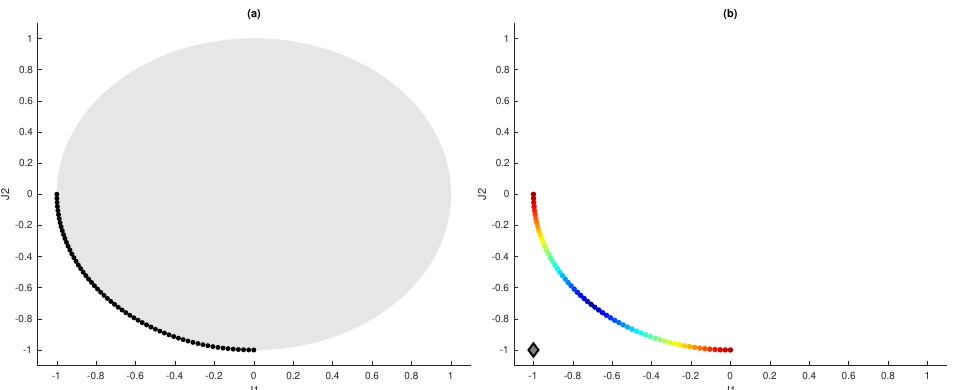
Figure 3. ( a ) Possible values of the objectives (grey disc) and approximation to Pareto front (black points). ( b ) Coloring Pareto front according to proximity to ideal point